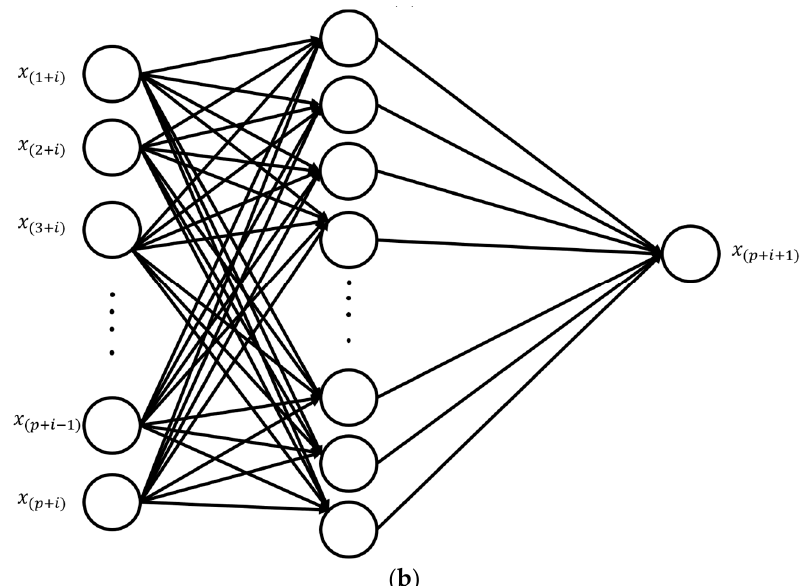
Figure 2. ( a ) The proposed algorithm was used in this study. ( b ) The structure of the neural network used in this study.